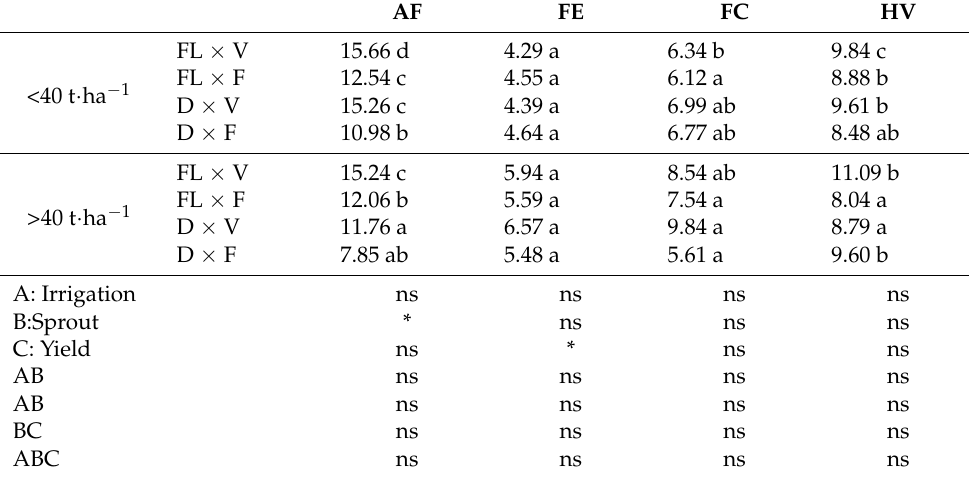
Table 8. Nutrient Balance Index (NBI) in the different phenological stages of ‘Rojo Brillante’ persimmon.